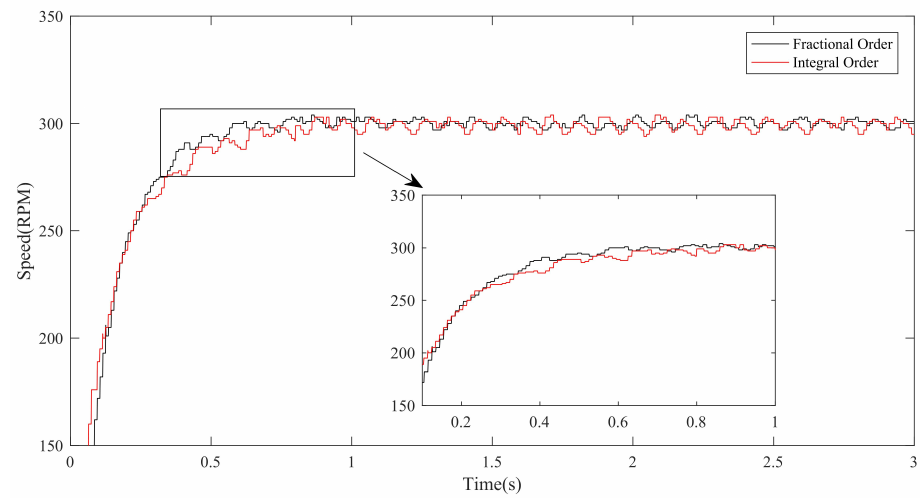
Figure 5. The response curves at low